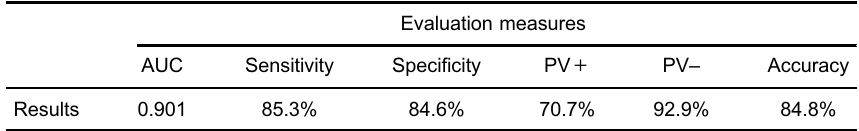
Table 3. Results of the decision tree model evaluation.